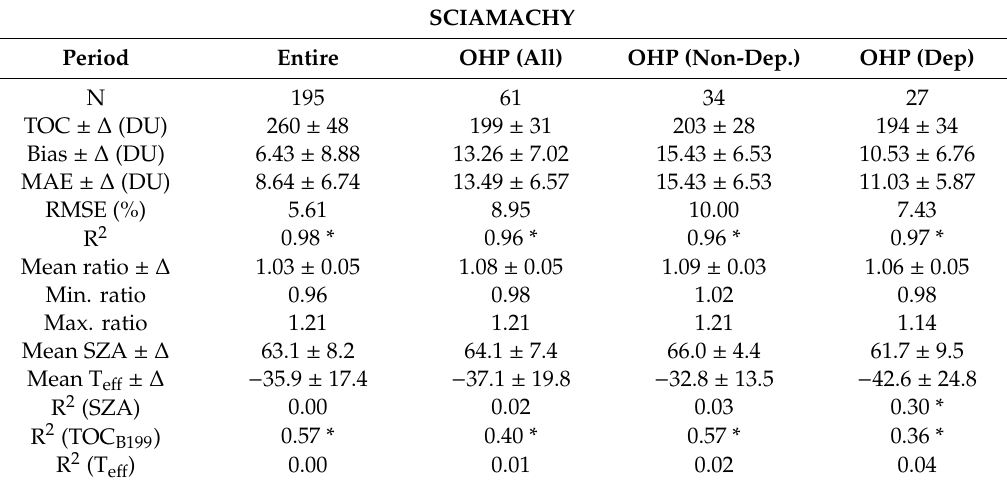
Table A3. Statistical characteristics calculated for individual data sources (asterisks indicate statistically significant ( α = 0.05)